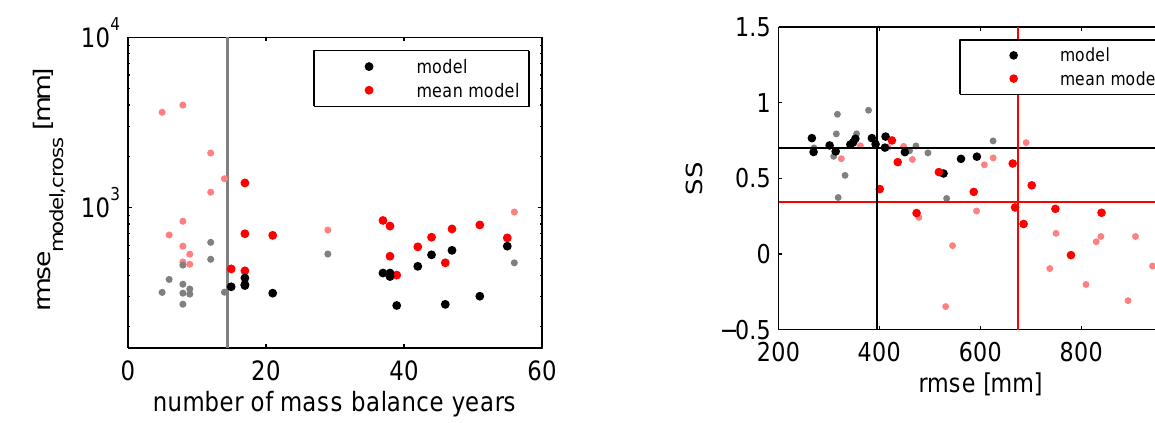
Fig. 6. SS model as a function of rmse model , cross . Black (red) dots are the values of the glaciers accepted into the final set, gray (light red) dots are those of the rejected glaciers. Red dots show the result of the mean model. Vertical and horizontal lines show the respective mean